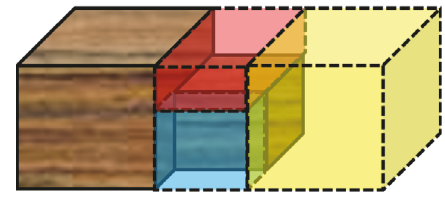
Figure 5: X-Z-Y division mode.